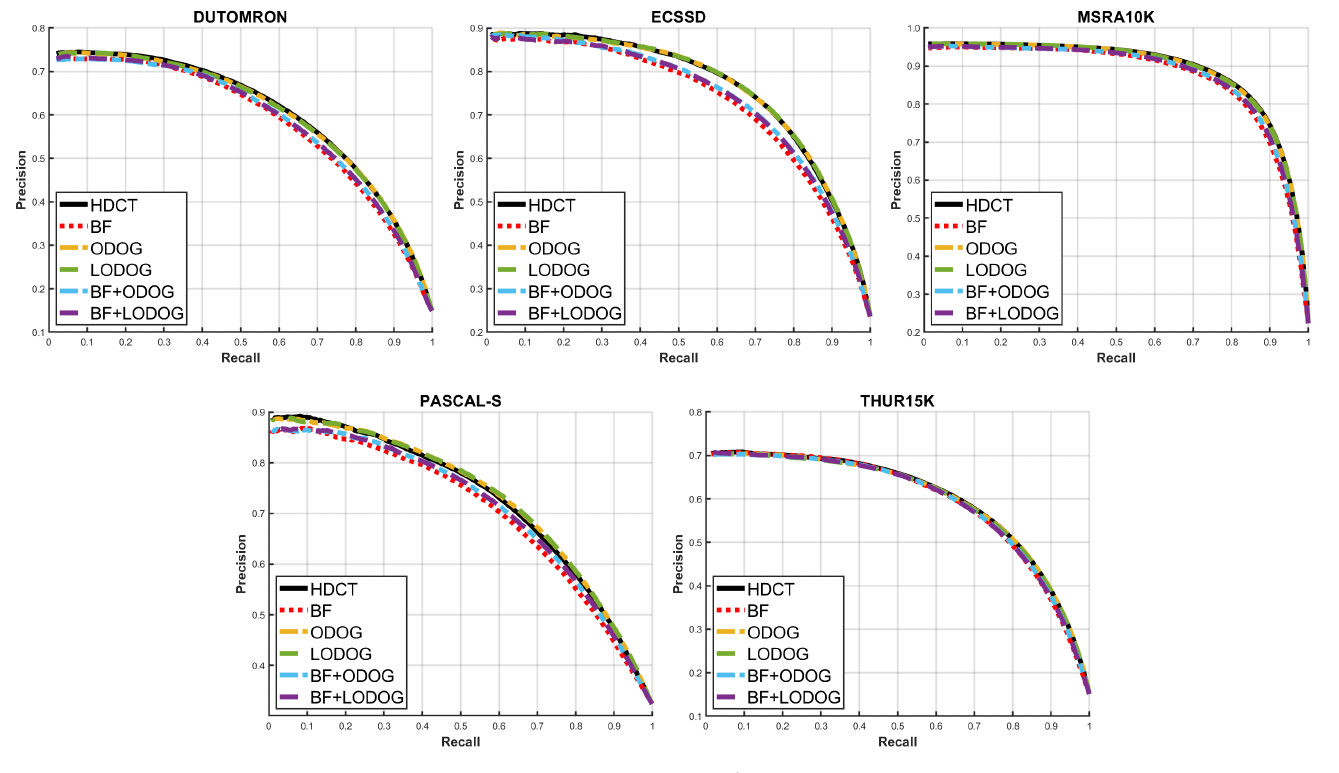
Figure 13. PR curve of HDCT.